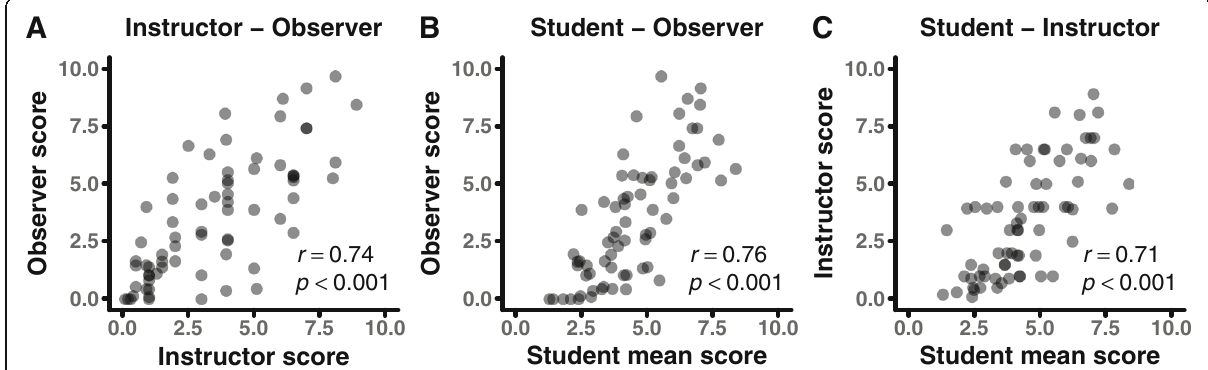
Fig. 4 Correlations in estimates of percent active learning between perspectives. Correlations between a instructor and observer responses, b student mean and observer responses, and c student mean and instructor response for proportion active learning item. Dots correspond to item response for each course; n = 70 total